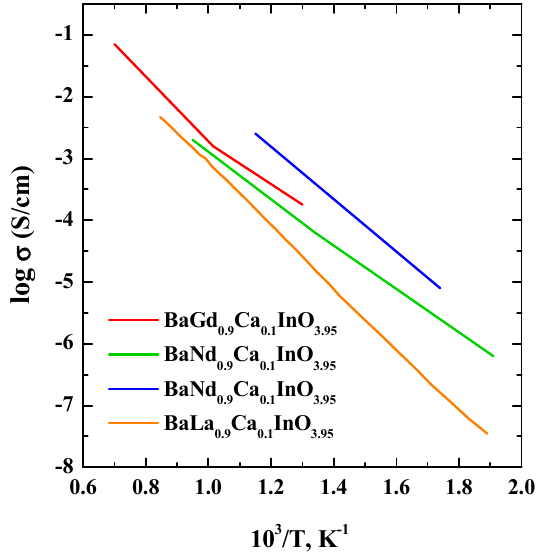
Figure 16. The temperature dependencies of electrical conductivities of the compositions BaGd 0.9 Ca 0.1 InO 3.95 (red) [115], BaNd 0.9 Ca 0.1 InO 3.95 (green) [82], BaNd 0.9 Ca 0.1 InO 3.95 (blue) [72], BaLa 0.9 Ca 0.1 InO 3.95 (orang) [76].